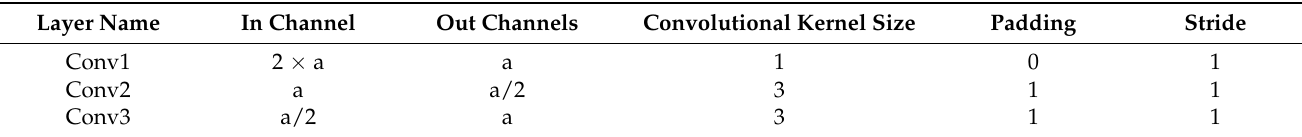
Table 2. Convolutional layer structure in fusion